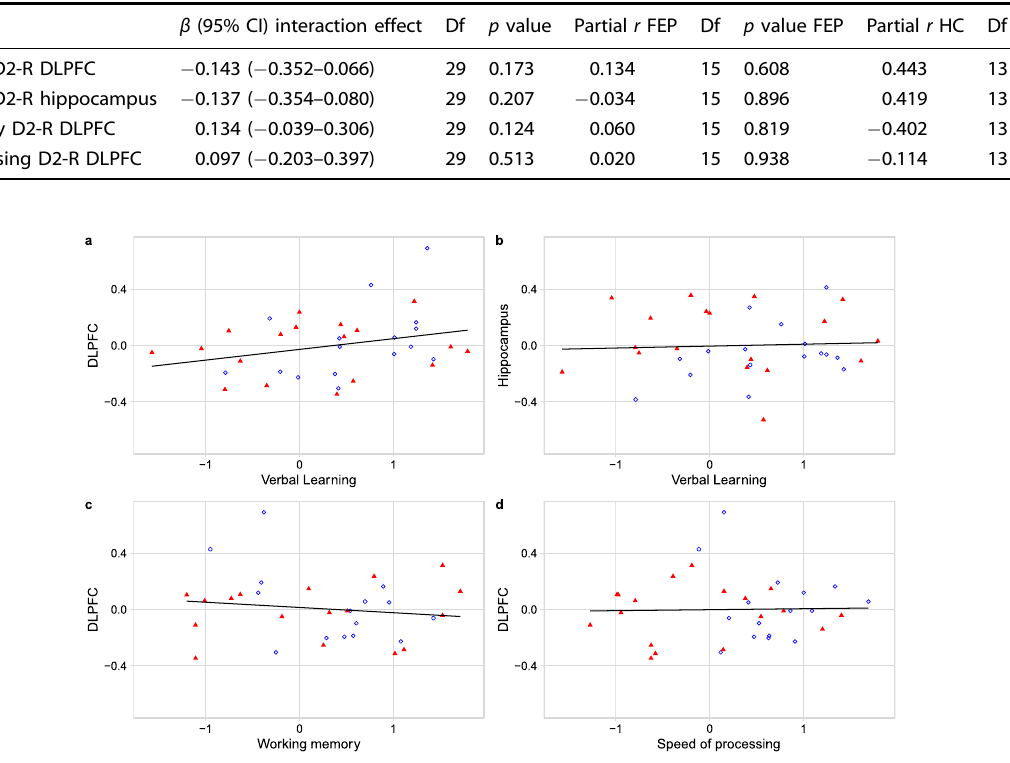
Table 4. Con fi rmatory analyses with an added interaction effect.